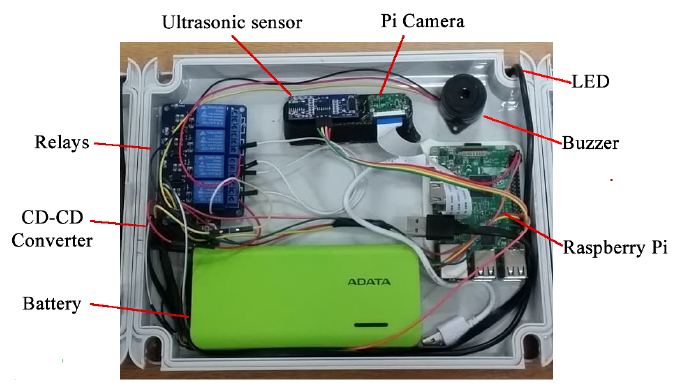
Figure 16. SPIN-V IoT Sensor